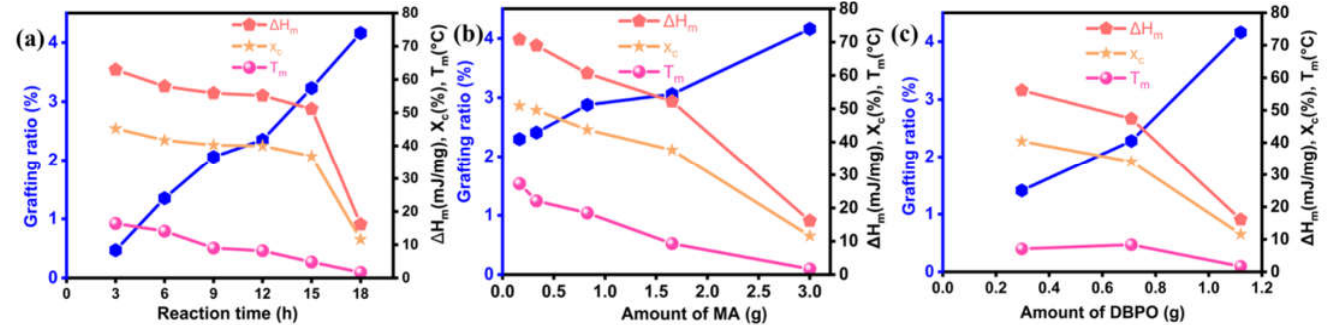
Figure 5. Influence of ( a ) reaction time, ( b ) amounts of MA and ( c ) amounts of DBPO on grafting ratio, T m , ΔH m and X c of synthesized PCL-g-MA. ratio, T m , ∆ H m and X c of synthesized PCL-g-MA.